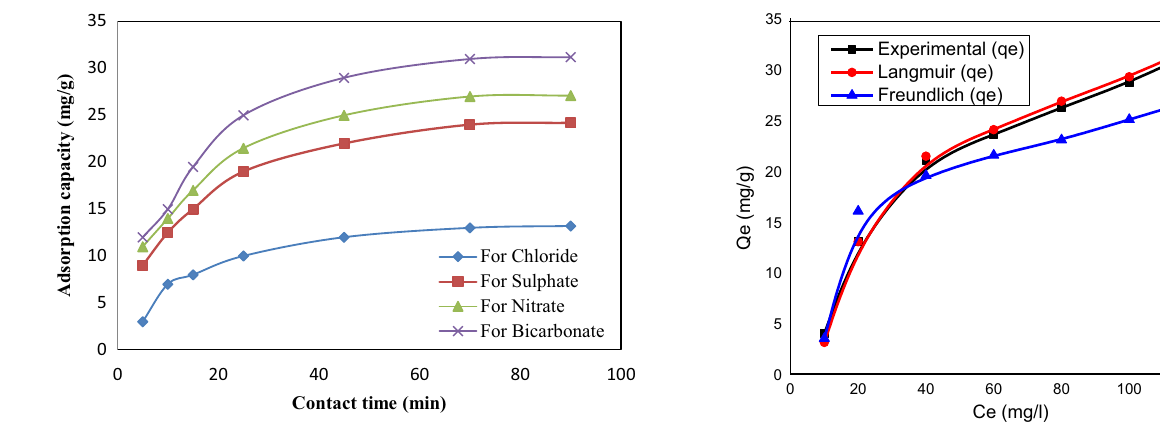
shows the adsorption isotherm studies at constant tempera- ture of 303 K.